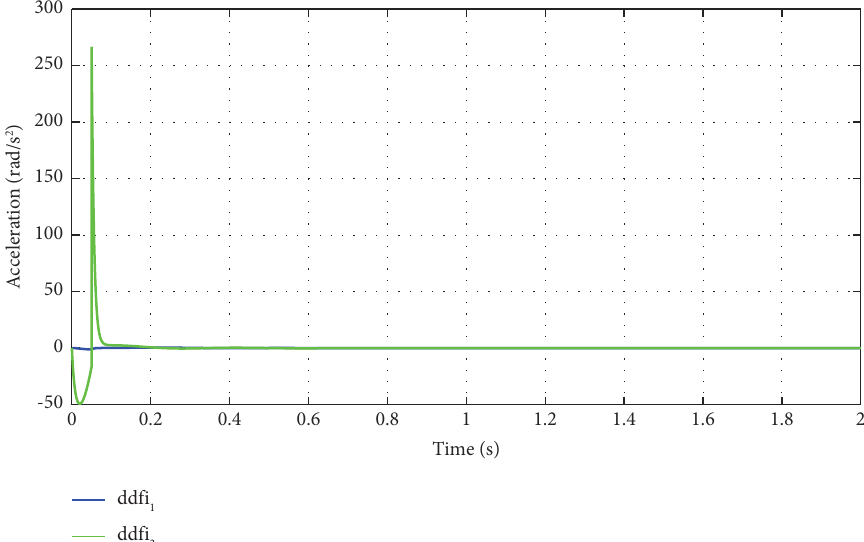
Figure 9: Angular accelerations of parts of the mobile antiaircraft weapon system after launch: ddf and ddf 2 -angular acceleration of the